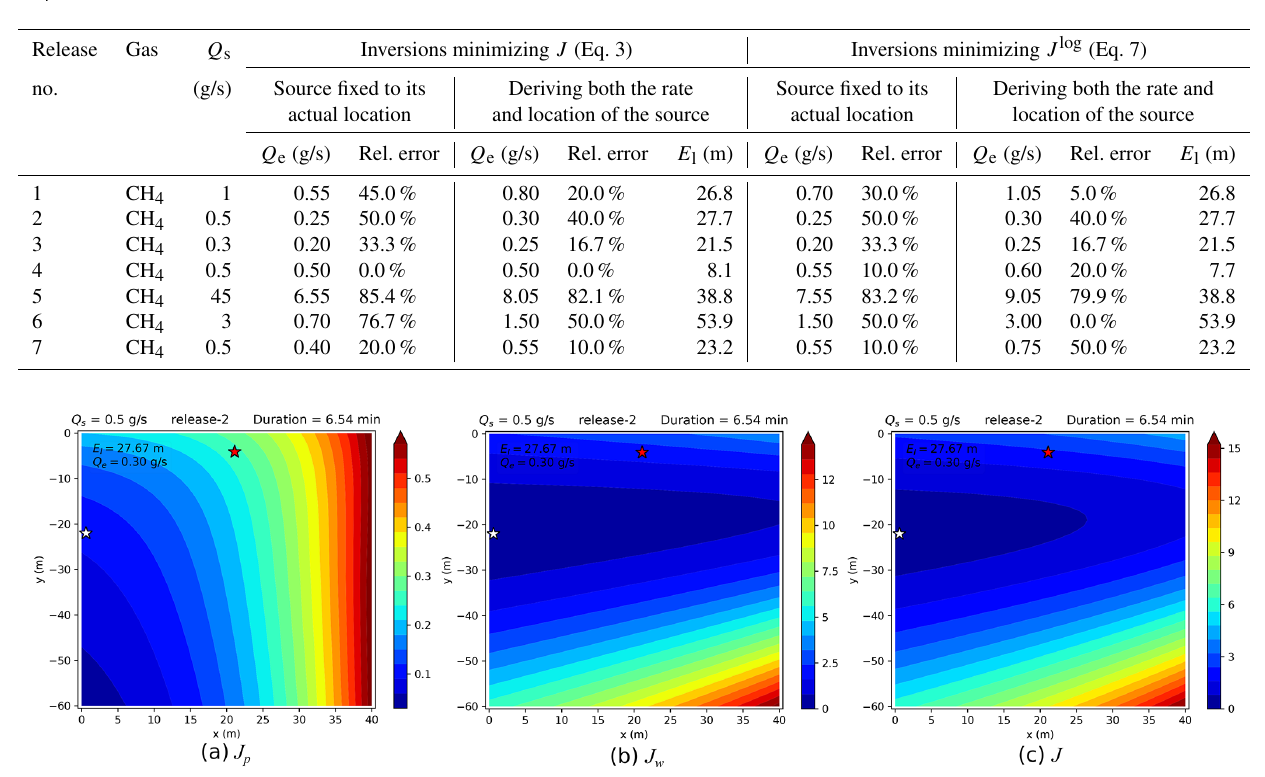
Table 3. Summary of the results from the inversions with comparisons between the actual and inverted source locations and rates for the CH 4 releases.